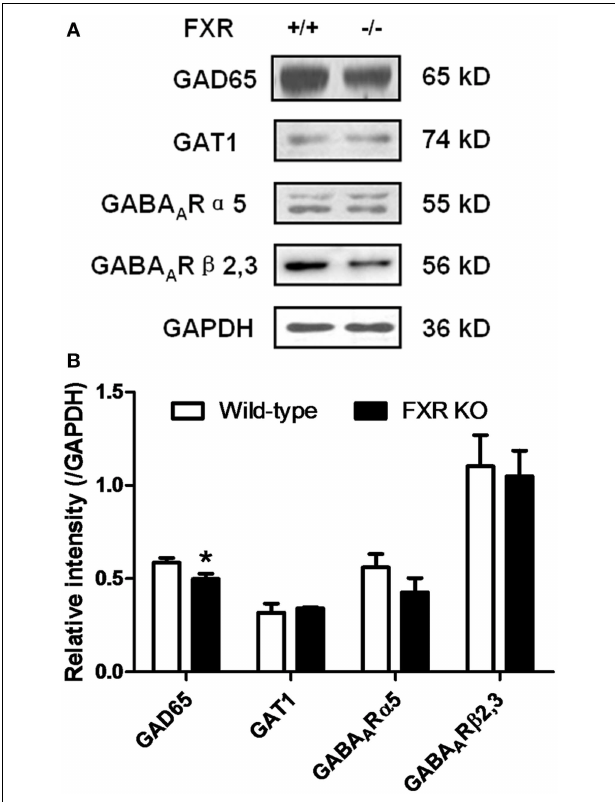
FIGURE 6 | FXR KO down-regulated hippocampal GAD65 of the mice. (A) Western blotting analysis of GAD65, GAT1, GABA A R α 5, and GABA A R β 2/3; (B) Gray intensity comparison. N = 8 /group; * p < 0 . 05 .